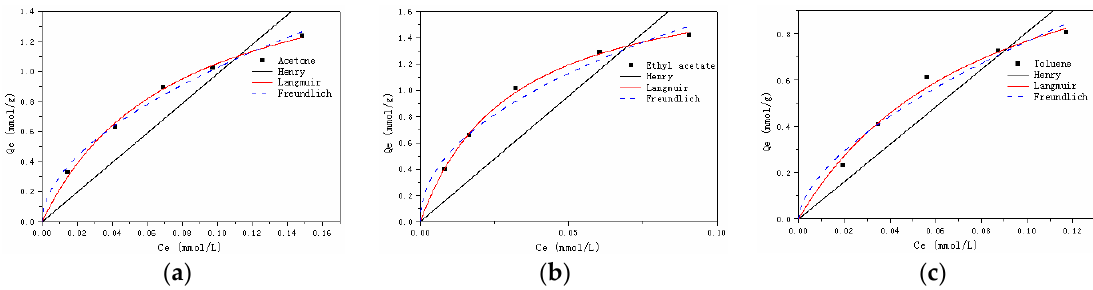
Figure 5. Equilibrium adsorption capacities of acetate ( a ), ethyl acetate ( b ) and toluene ( c ) at different